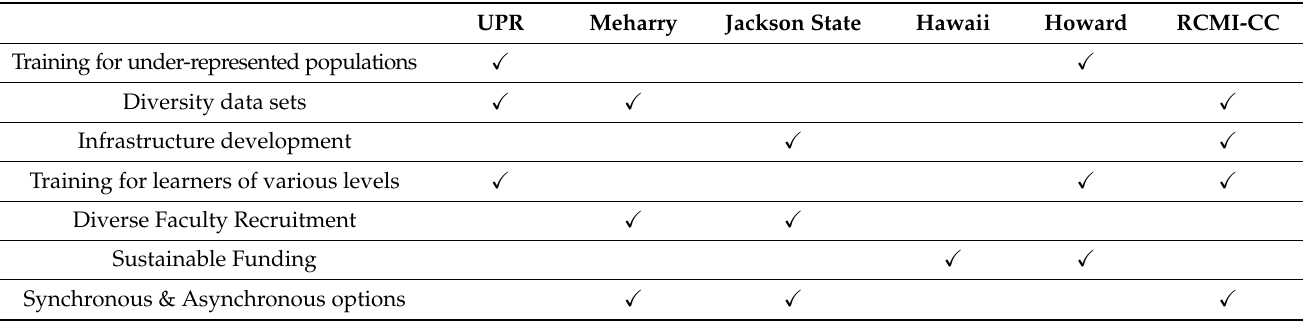
Table 9. Summary of recommendations by program